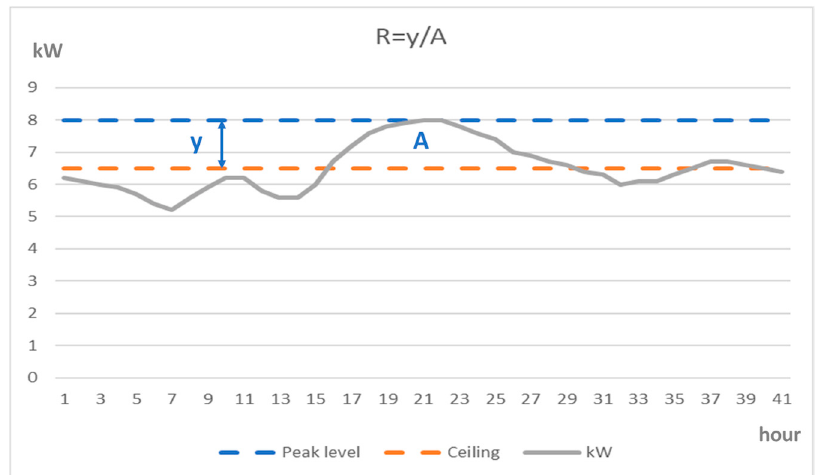
Figure 2. Consumption curve with low, round power peaks that require relatively high energy den- sity in relation to power; R is thus low.